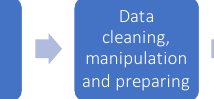
Figure 1. Flow diagram of the adopted